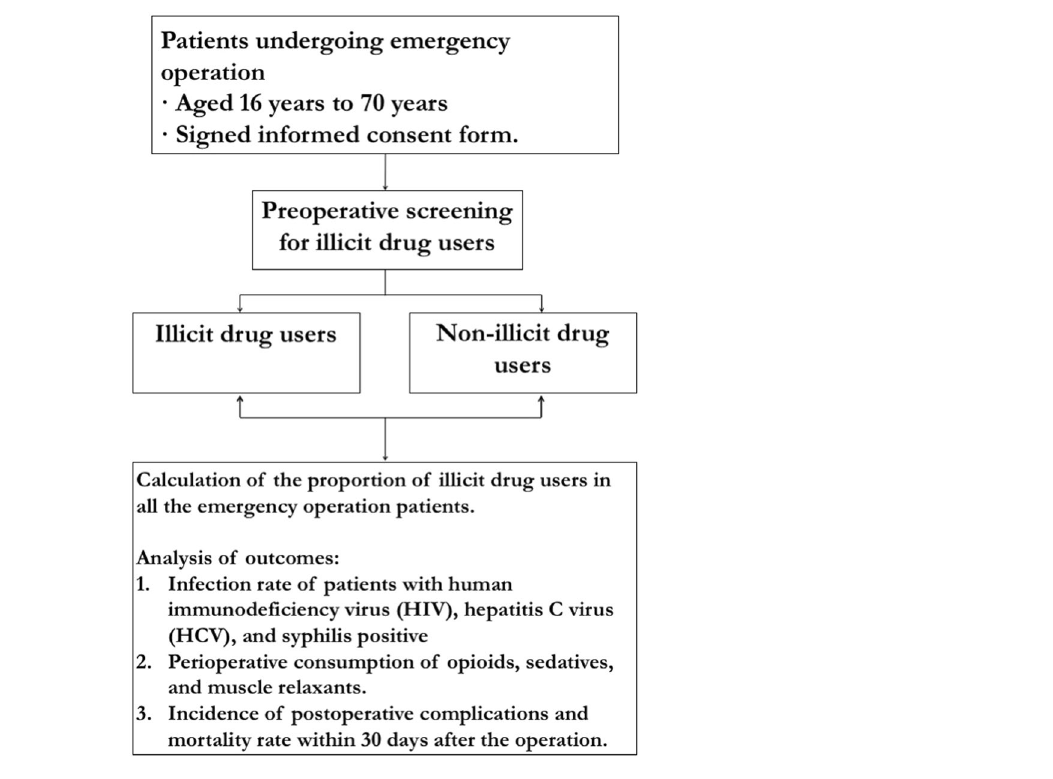
Figure 1. The study